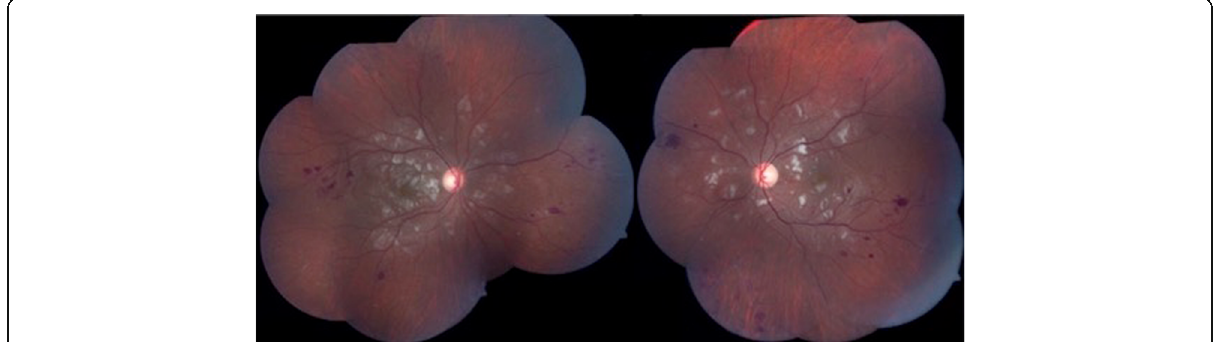
Fig. 2 Composite color fundus photographs of both eyes demonstrate cotton wool spots in the posterior pole and multiple retinal hemorrhages along with vascular sheathing in the peripheral retina of a patient with primary antiphospholipid